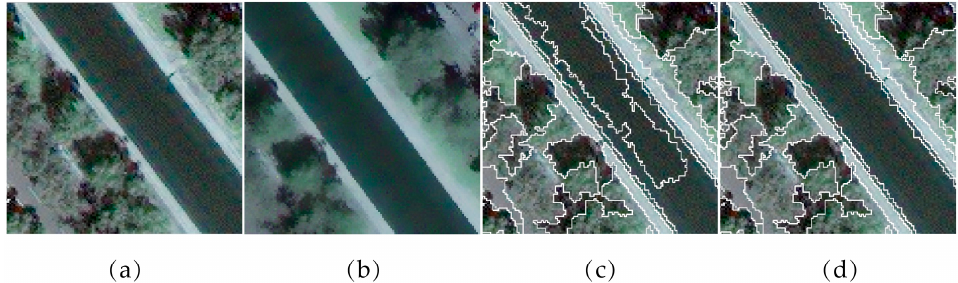
Figure 2. ( a ) The raw sample image; ( b ) the spectral feature image extracted from ( a ) using the bilateral filter ( σ s = 3; σ r = 0.1 ) ; ( c ) the segmentation results of image ( a ) at scale 50; and ( d ) the segmentation results of image ( a ) at scale 55. The object boundaries are delineated by the white line.